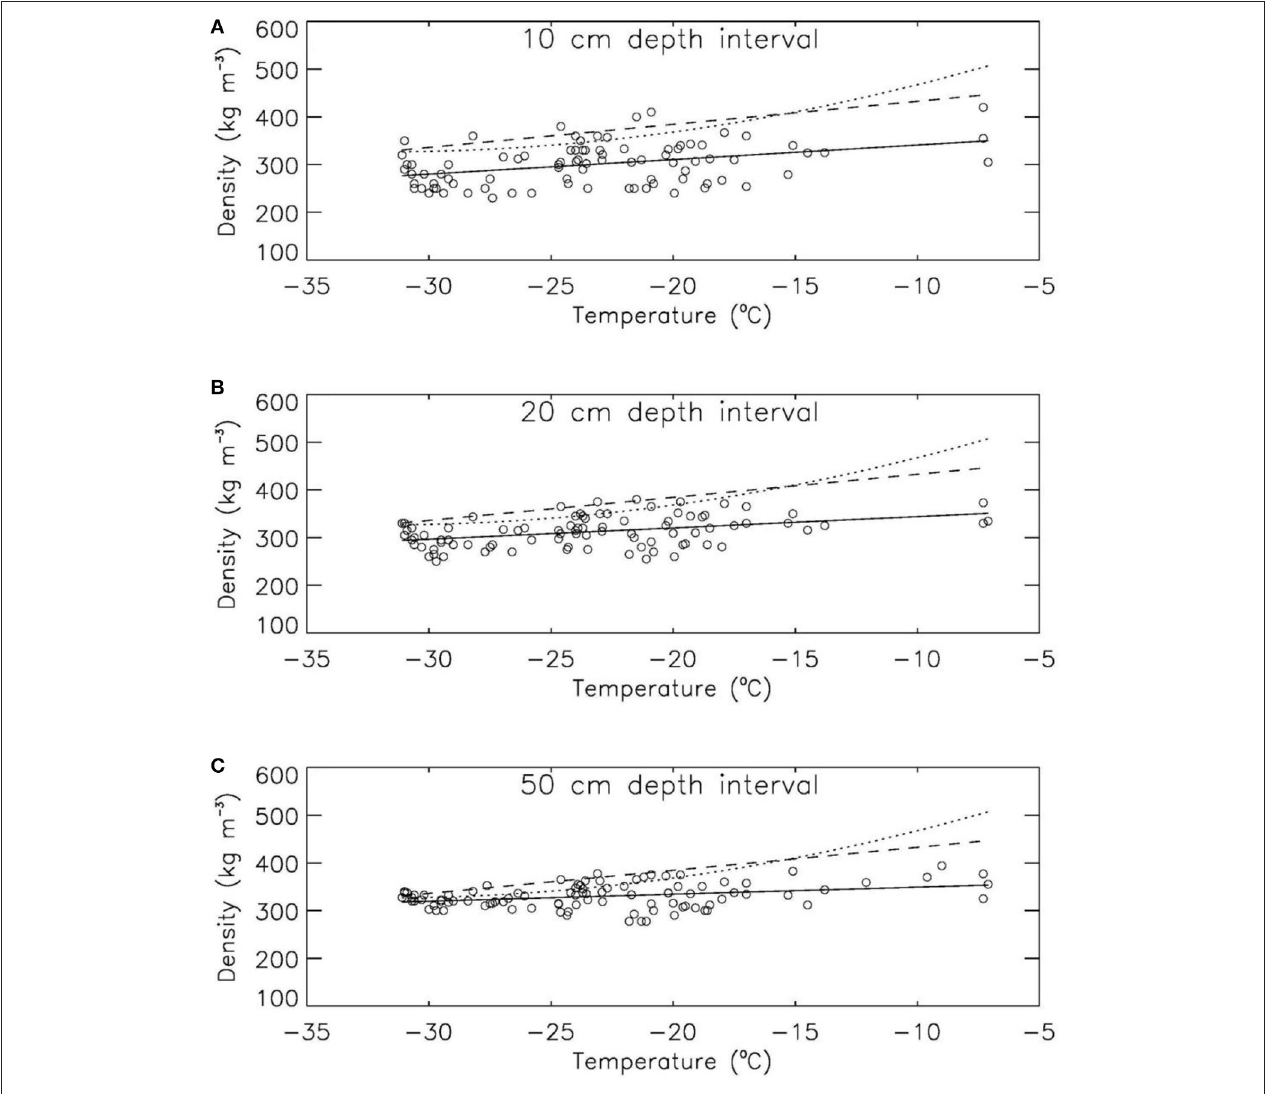
FIGURE 4 | Orthogonal linear regression fits (solid lines) for temperature-dependent parameterization P1 ( Table 1 ) for (A) depth range 0–0.1m, (B) depth range 0–0.2m, and (C) depth range 0–0.5m. Circles represent our observational dataset. Parameterizations by Kuipers Munneke et al. (2015) and Reeh et al. (2005) are plotted as dashed and dotted lines,